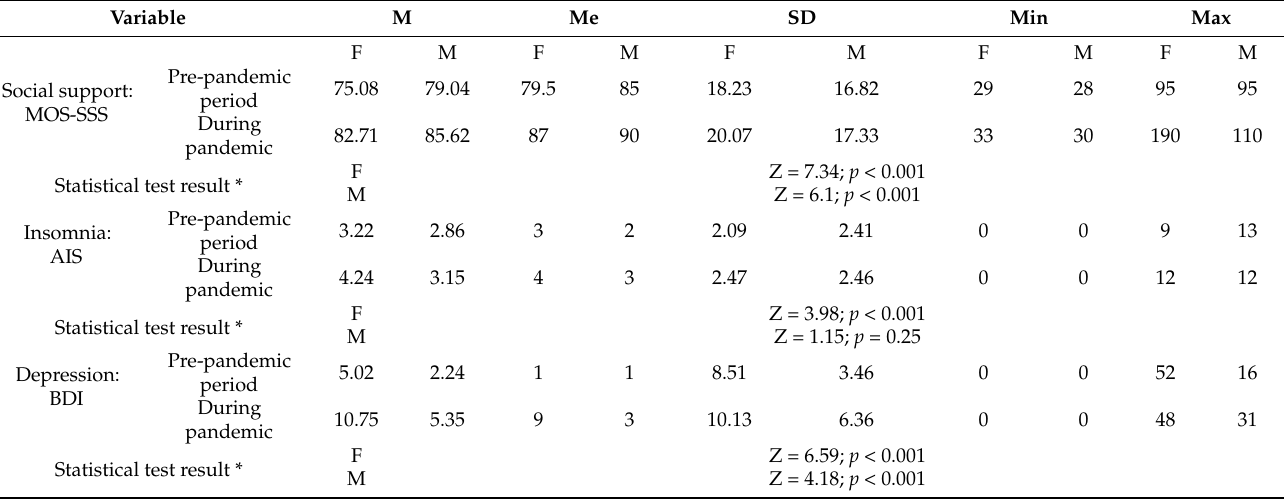
Table 3. Comparison of social support, sleep disorders and depressive symptoms in the pre-pandemic period and during the pandemic among healthcare professionals depending on gender.